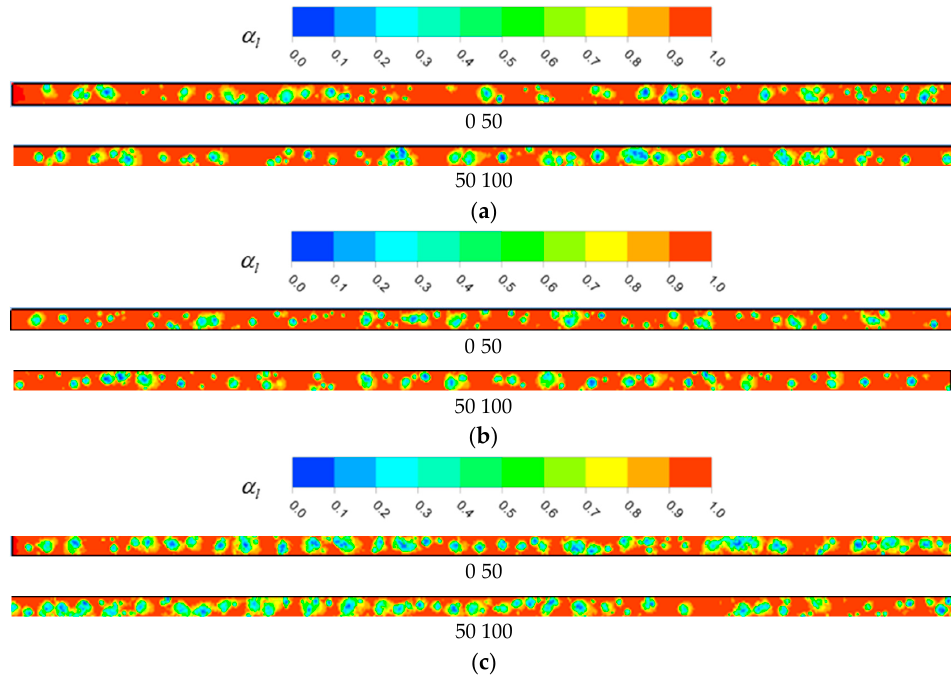
Figure 5. Volume fraction distribution of R744 liquid phase at different heat fluxes: ( a ) T sat = 253 K, G = 50 kg/m 2 s, q = 10 kW, X = 0.28; ( b ) T sat = 253 K, G = 50 kg/m 2 s, q = 20 kW, X = 0.56; ( c ) T sat = 253 K, G = 50 kg/m 2 s, q = 30 kW, X = 0.84.